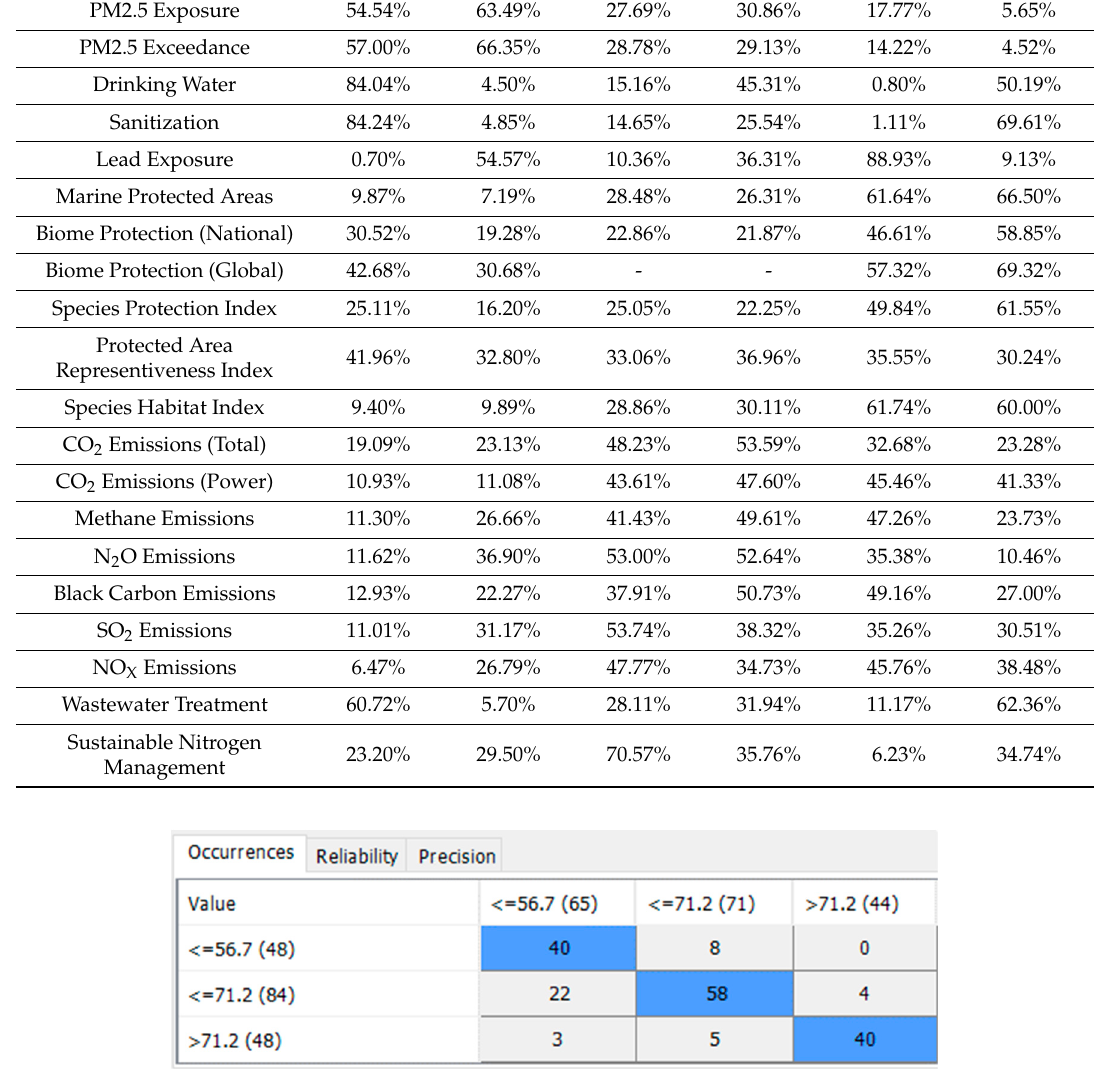
Figure 9. Confusion matrix of reliability.